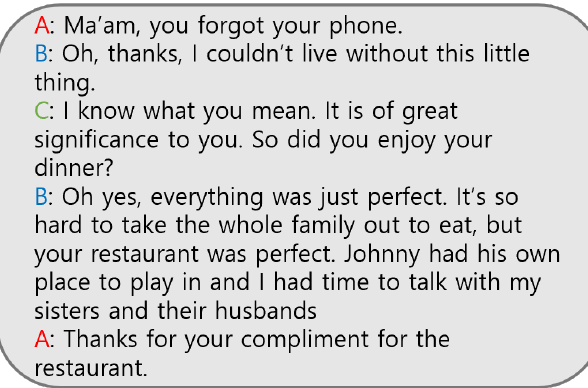
Figure 5. A multi-party